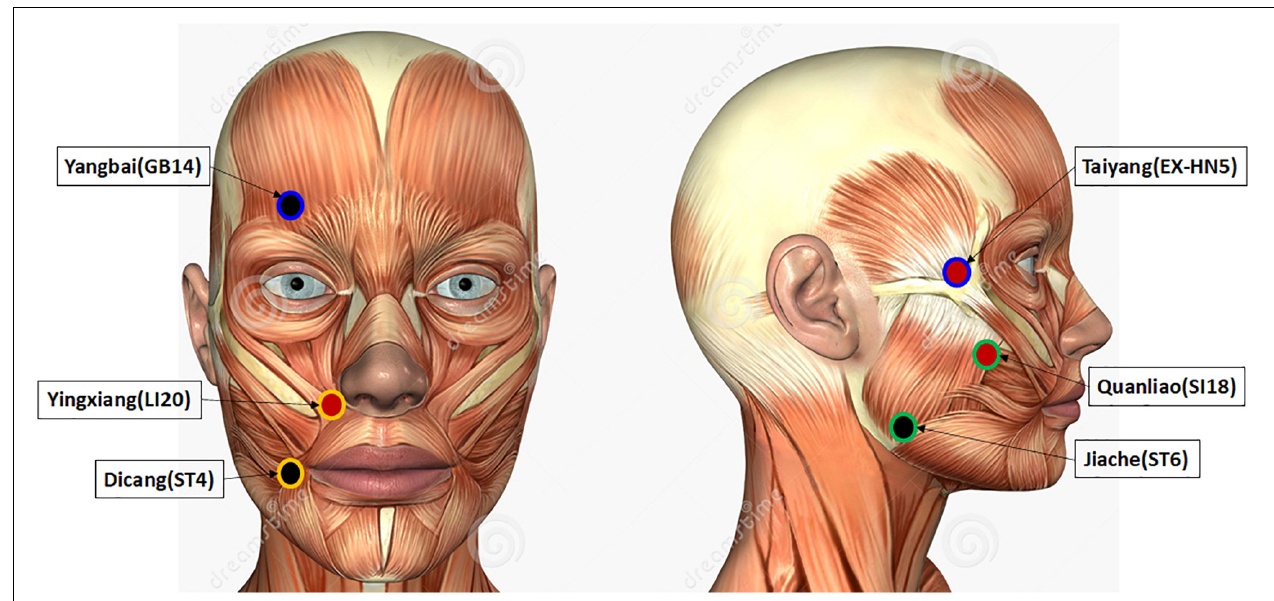
FIGURE 1 | Illustration of the stimulated acupoints. The acupoints colored in red were connected with positive electrodes, and the acupoints colored in black were connected with negative electrodes. Each pair of electrodes was circled with a same